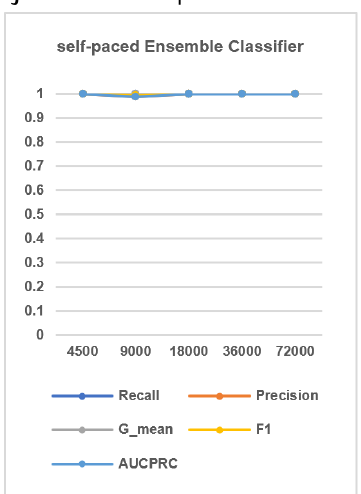
Figure 18. self-paced: Impact of Dataset